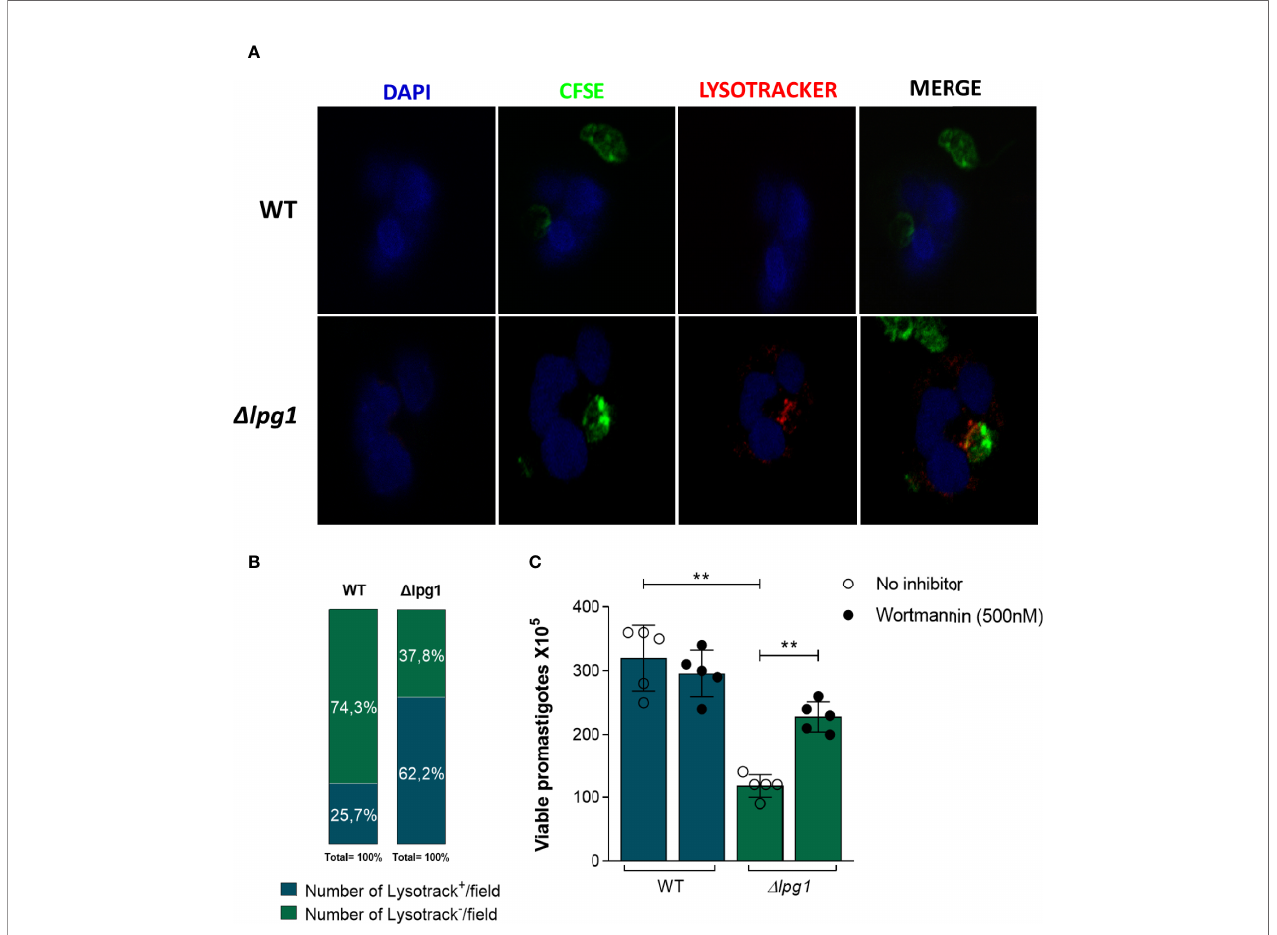
FIGURE 2 | Impact of neutrophils ’ acidic compartments on survival of Lpg1 - null mutant parasites. (A) Human neutrophils were infected with L. infantum WT or Δ lpg1 stained with carboxy fl uorescein succinimidyl Ester (CFSE) in green and incubated with Lysotracker (lysosomal district marker) in red and with DAPI (nuclear mark) in blue. After 3 h, acidic parasitophorous vacuoles in neutrophils were imaged for colocalization using a fl uorescence microscopy, and representative data are shown (A) . Frequency of neutrophils staining positive for Lysotracker per microscopy fi eld was compared between the groups of cells infected with WT or Δ lpg1 parasites. Data were compared using the Pearson chi-square test ( p < 0.05) (B) . Human neutrophils, treated or not with Wortmannin (500 nM), were infected with L. infantum WT or Δ lpg1 for 3 h, when RPMI was replaced by HOMEM medium. Count of released viable promastigotes in supernatant was performed after 24 h (C) . Each point in the graphs represents a donor; bars represent median values and whiskers infer interquartile ranges. Asterisks indicate statistically signi fi cant differences evaluated through the non-parametric Mann – Whitney U test (** p <